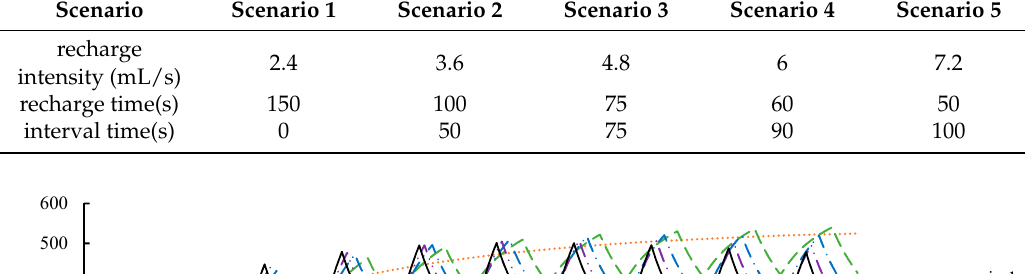
Table 4. Scenarios of different recharge period.